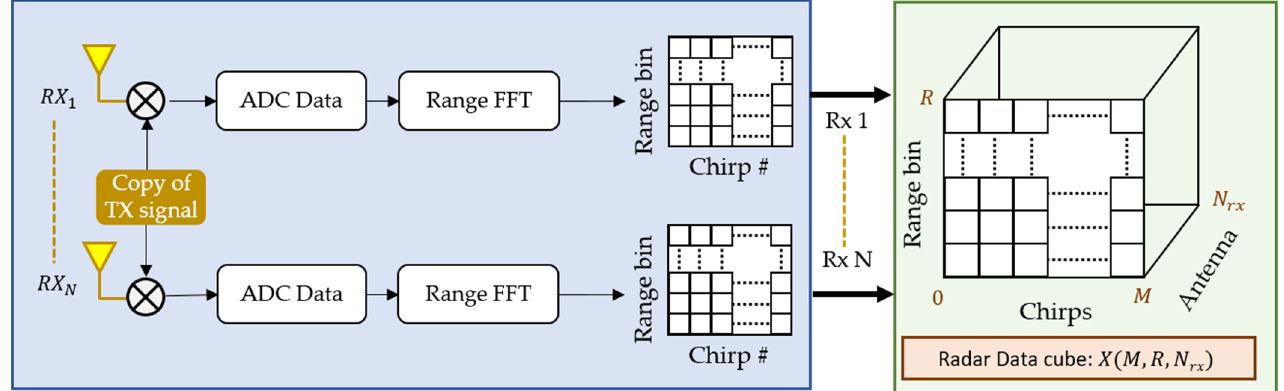
Figure 3. Extraction of radar data cube (RDC) from the received signal at different antennas.